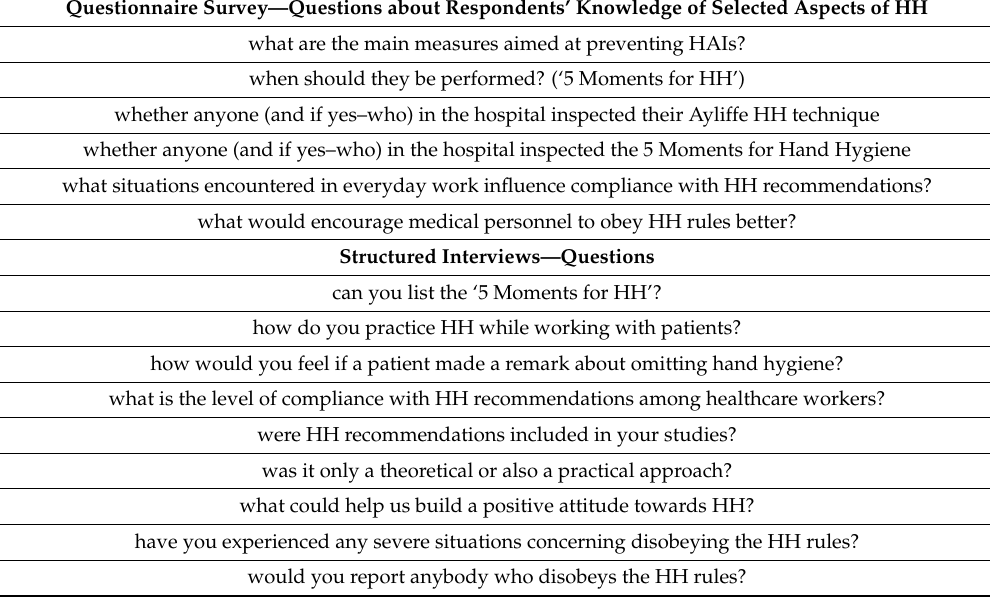
Table 1. Questions used in the questionnaire survey and in structured